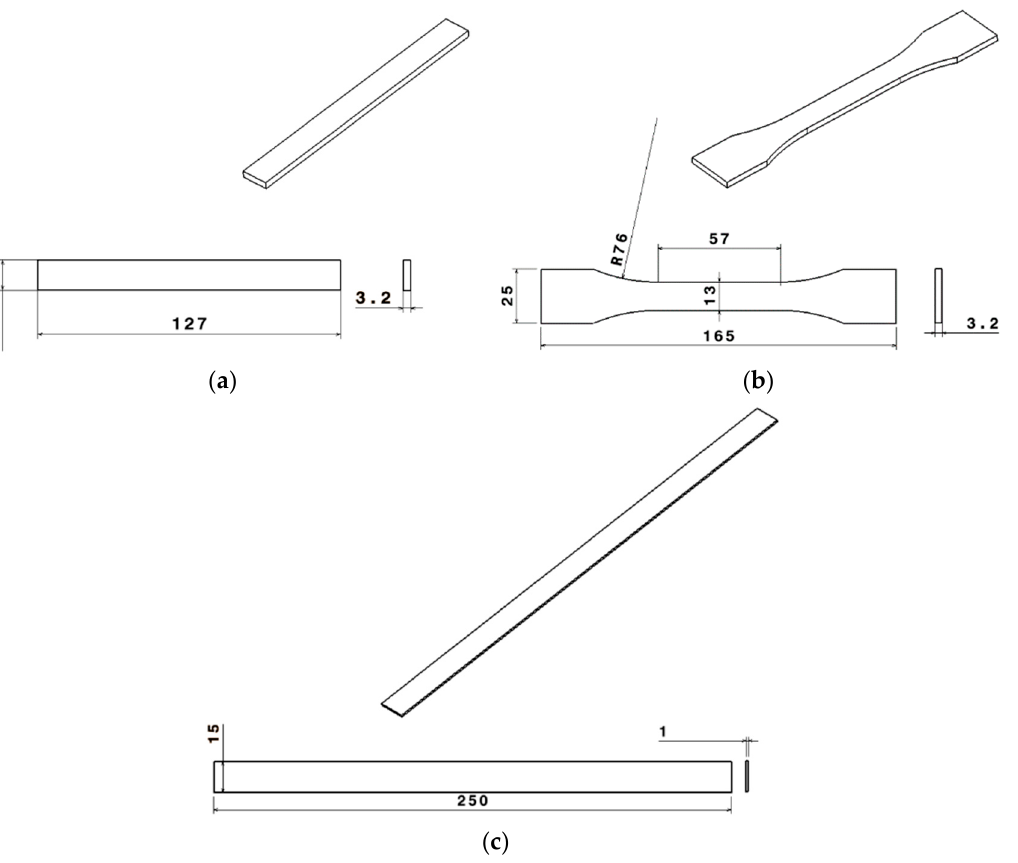
Figure 3. Specimens’ geometries according to standards: ( a ) three-point bending test; ( b ) tensile test—plastic; ( c ) tensile test—composite (reinforced ONYX).